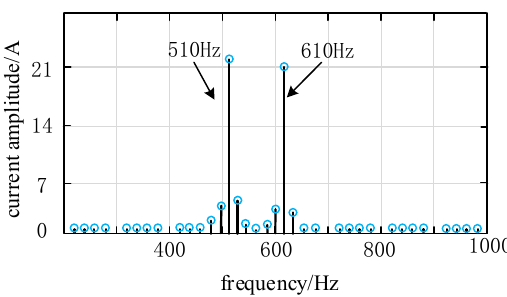
Figure 12. FFT spectrum diagram of the modal detection link.